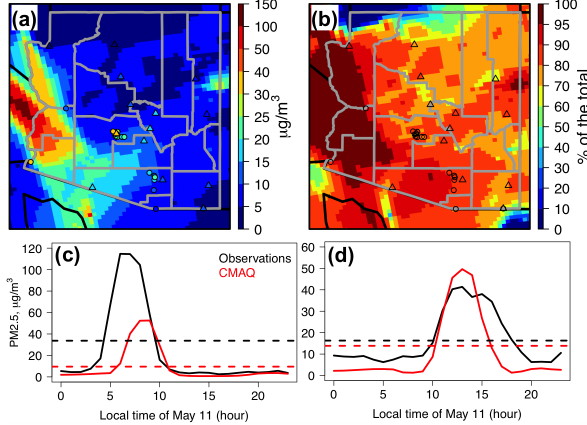
Figure 6. (a) NAQFC 12km CMAQ modeled 24h mean surface PM2.5 on 11 May 2014, with the AirNow (circles) and IMPROVE (triangles) observations overlaid. (b) CMAQ modeled dust contri- butions (%) to the total PM2.5 on this day. Locations of AirNow (circles) and IMPROVE (triangles) are shown. Observed (black) and modeled (red) surface PM2.5 in (c) Maricopa and (d) Pima counties on this day, at AQS (solid lines) and IMPROVE (dashed lines)